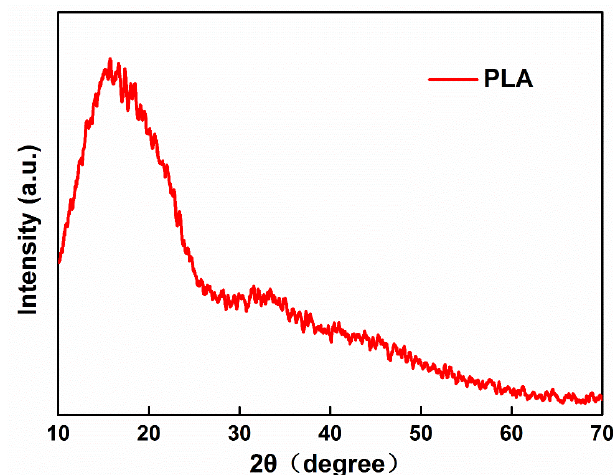
Figure 9. XRD Patterns of PLA fibers.